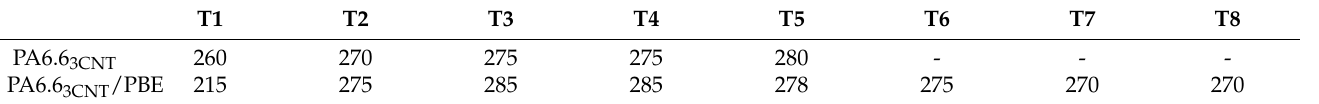
Table 2. Extrusion temperatures